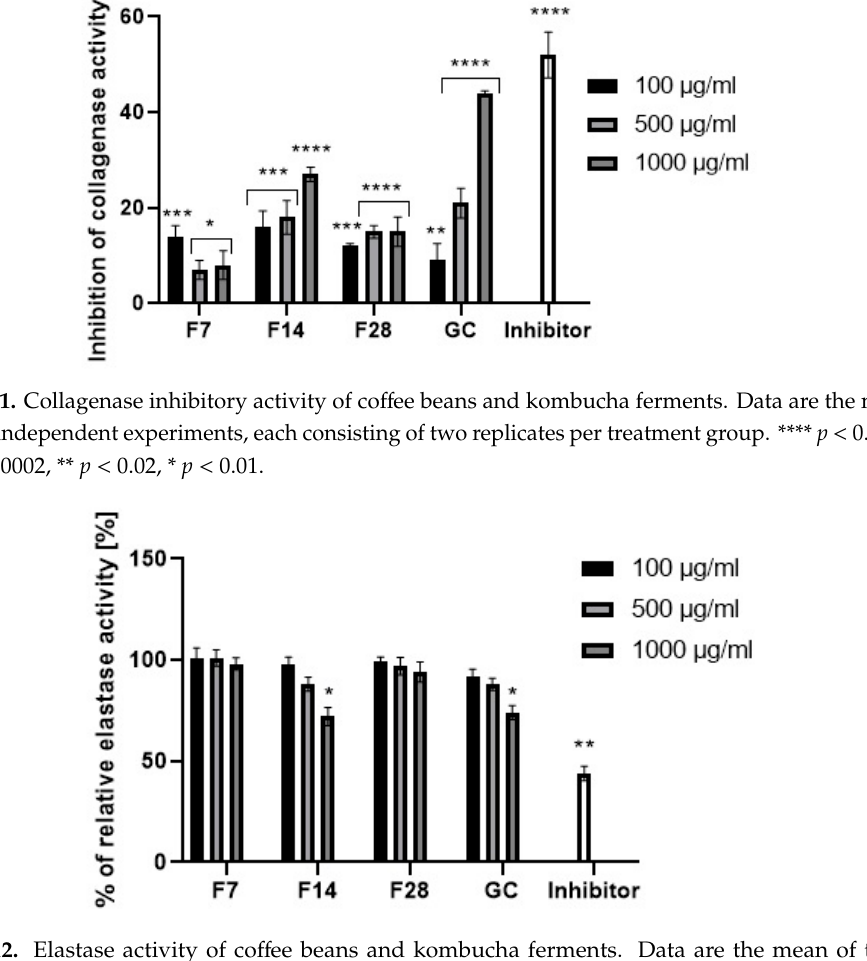
Figure 12. Elastase activity of coffee beans and kombucha ferments . Data are the mean of three independent experiments, each consisting of two replicates per treatment group. ** p < 0.03, * p < 0.01. Green coffee extract showed the ability to inhibit both collagenase and elastase. Stronger